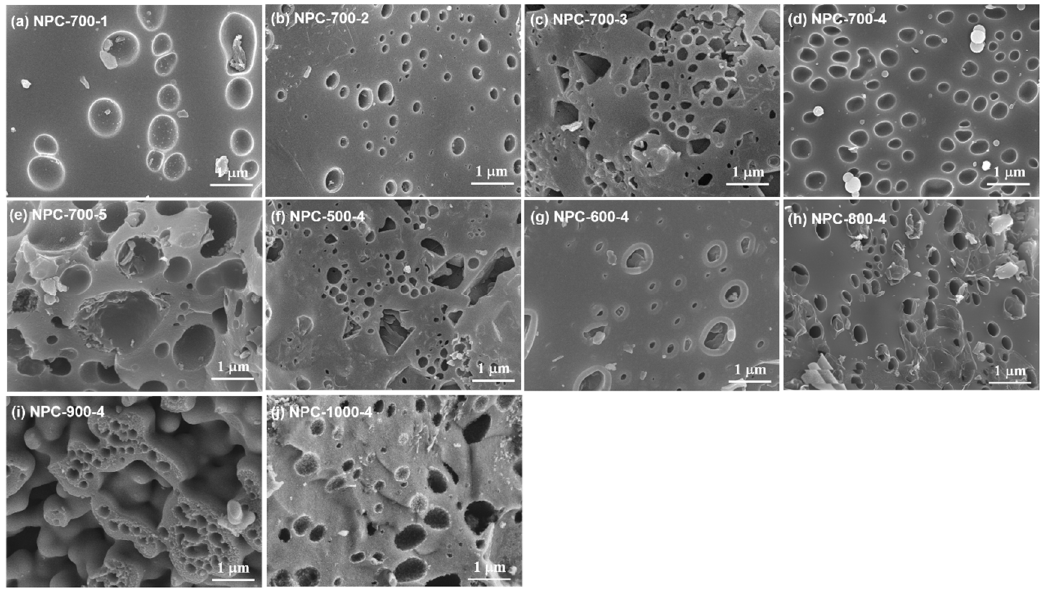
Figure 4. SEM images of NPC-700-x ( a – e ) and NPC-y-4 ( f – j ).